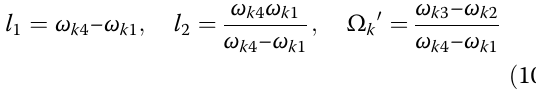
p(cid:7) ffiffiffiffiffiffiffiffiffiffiffiffiffiffiffiffiffiffiffiffiffiffi ffiffiffiffiffiffiffiffiffiffiffiffiffiffiffiffiffiffiffiffiffiffi 1 þ 4 a 2 = a 1